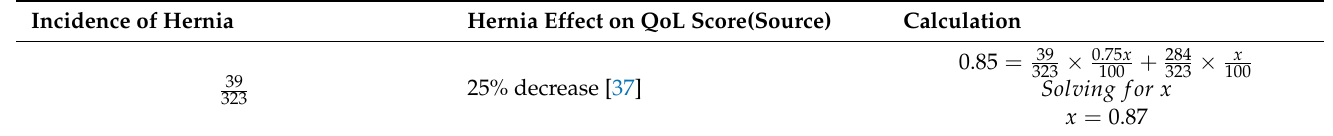
Table A8. Calculations for the utility of having a hernia based on expected difference in QoL score from